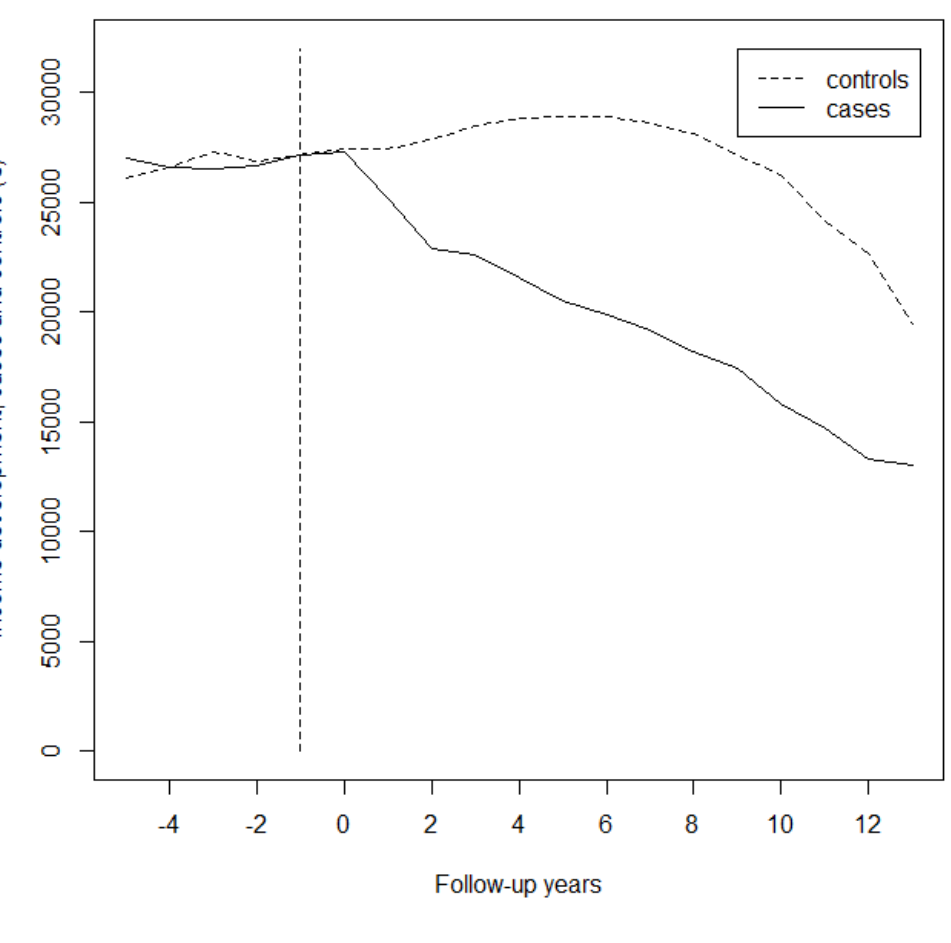
Figure 1: Income development by follow-up years, for cases and